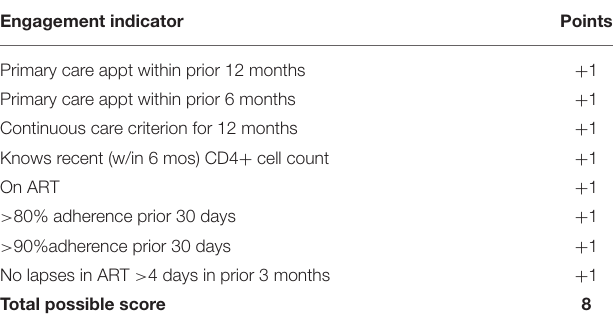
TABLE 4 | Behavioral composite scores and virologic